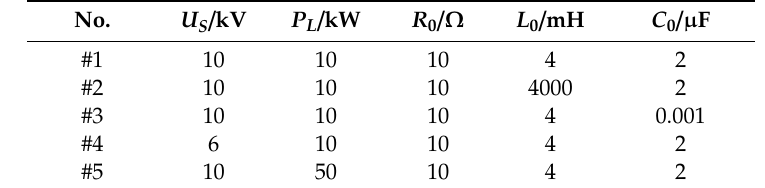
Table 6. Five Saber parameter sets for large-signal stability simulation of a multi-node CSO undersea DC power system.